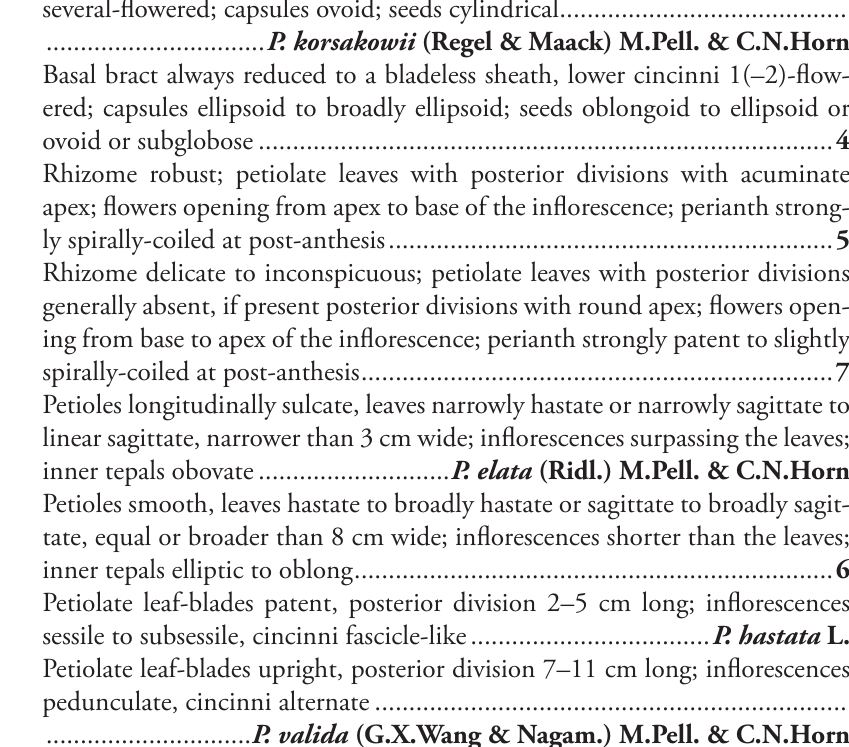
Basal bract leaf-like, rarely reduced to a bladeless sheath, lower cincinni 3–